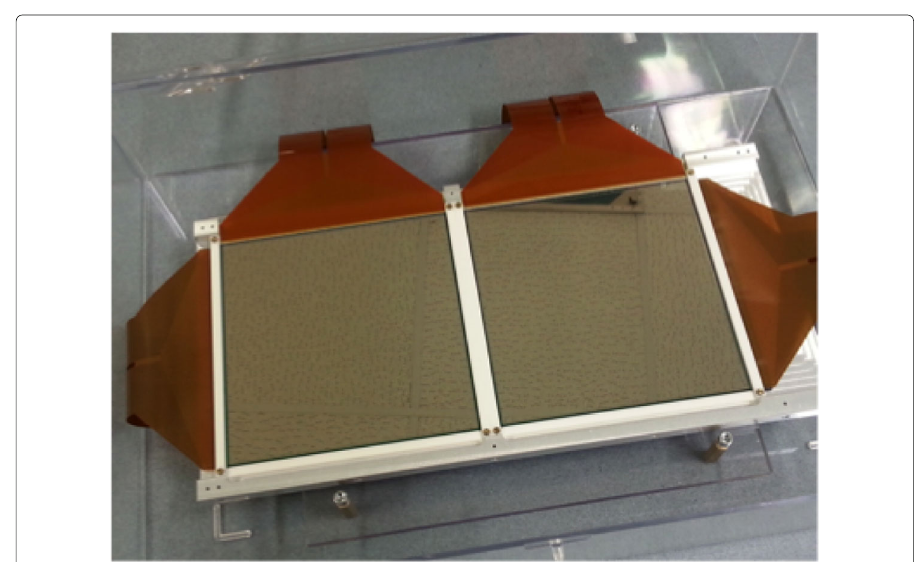
Fig. 13 Second layer of the detector with the TTT2 300 μ m thick sensors